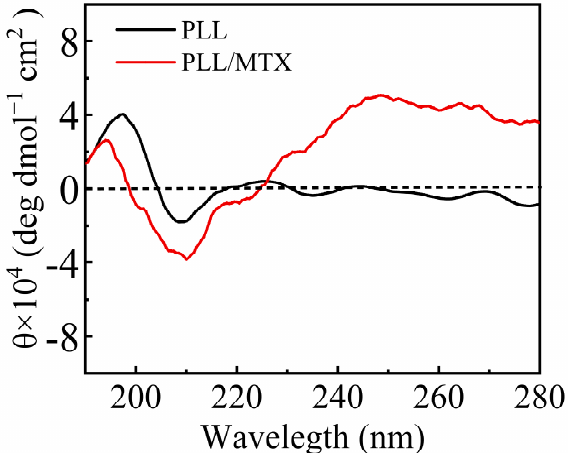
Figure 2. CD spectra of PLL and PLL/MTX